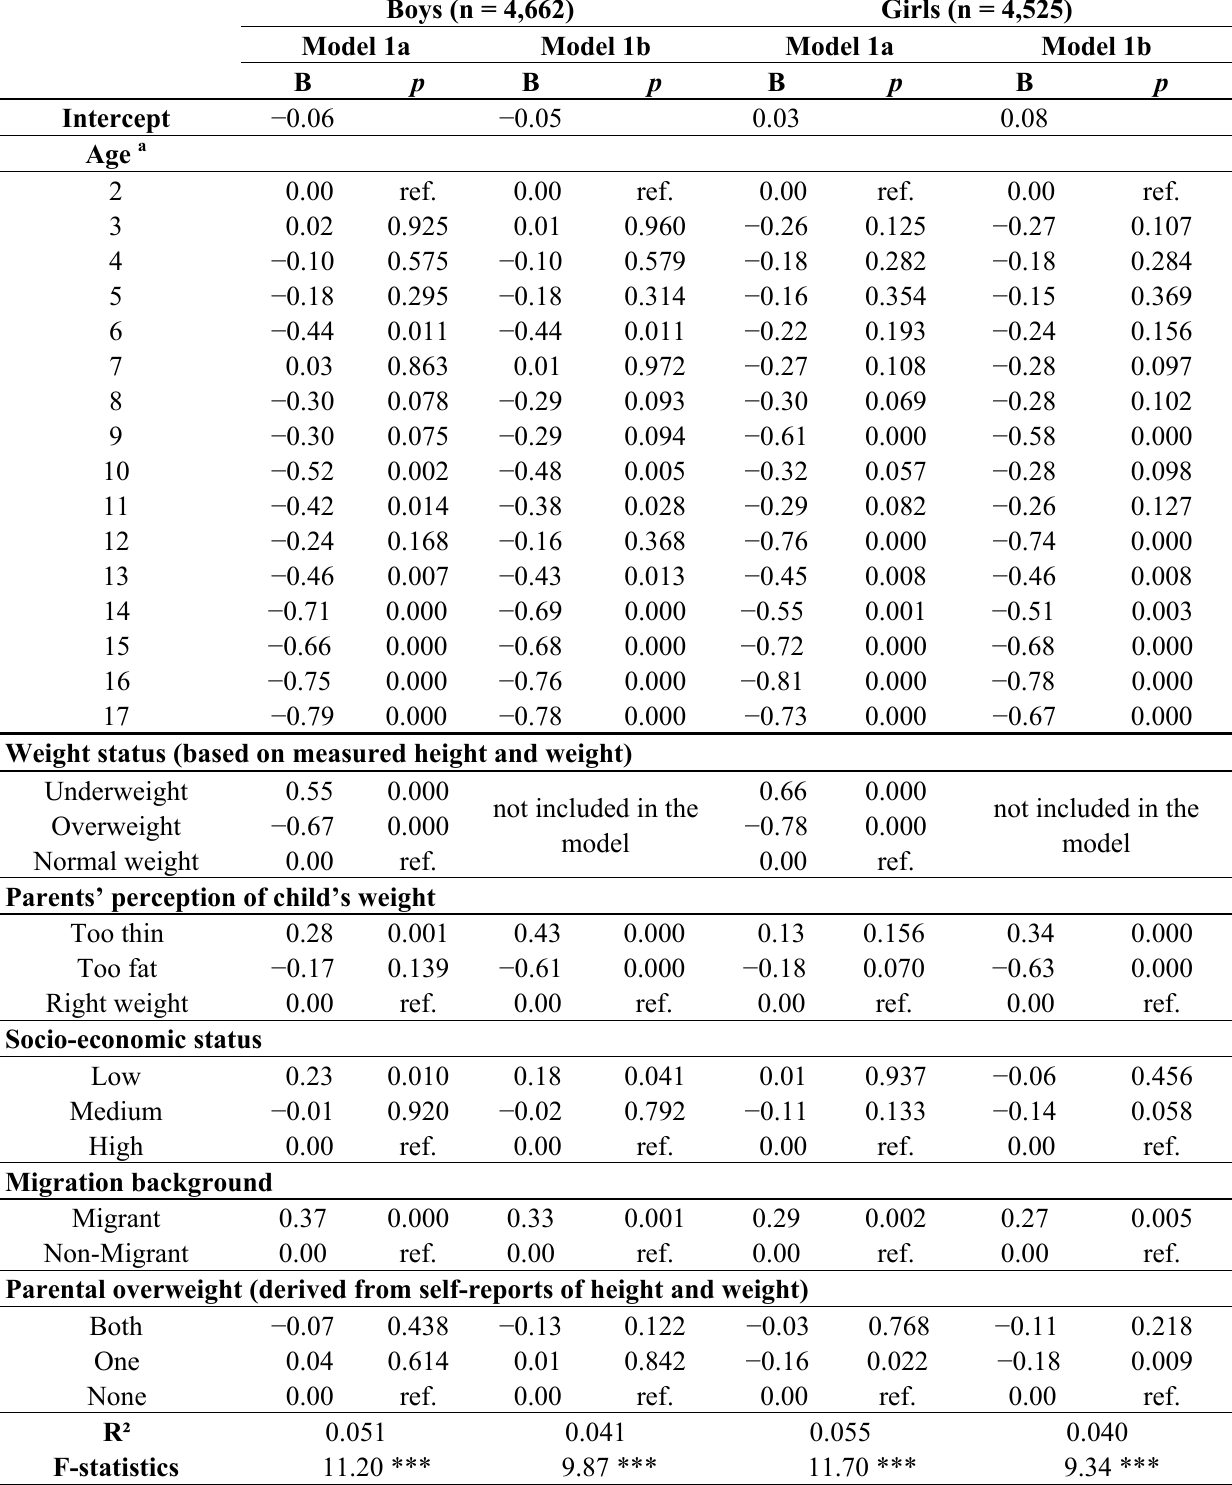
Table 4. Summary of multiple linear regression models of BMI difference derived from parent-reported and measured height and weight for boys and